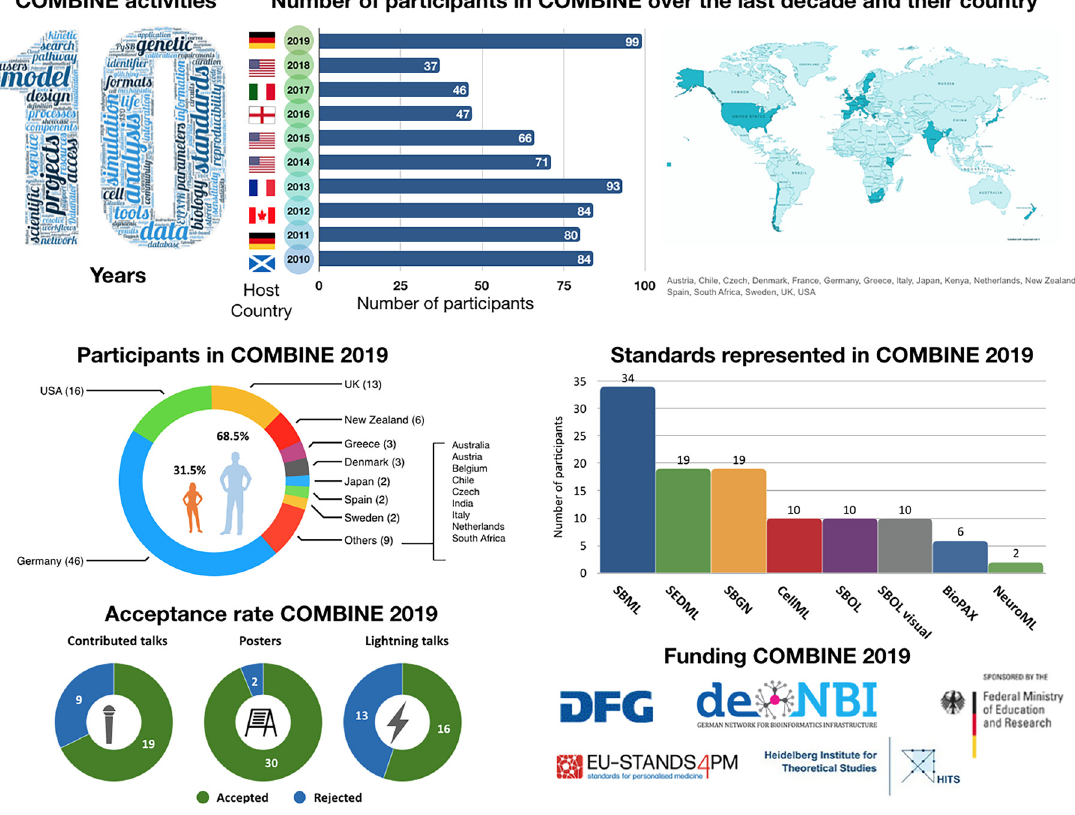
Figure 1: Statistics on attendees of COMBINE